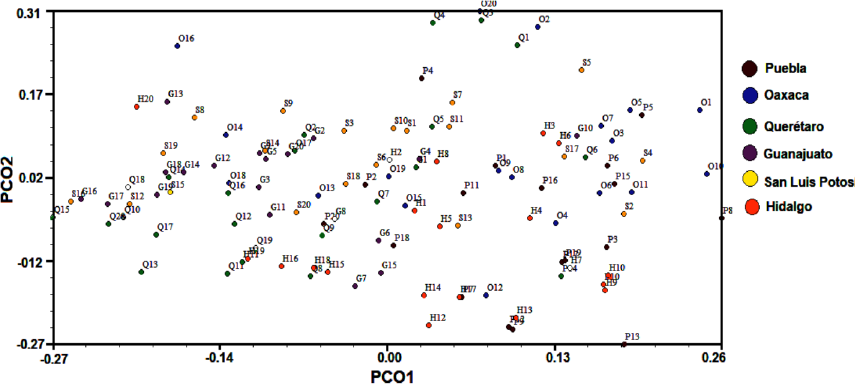
Figure 4. Two dimensional plot of the PCO-MC clustering analysis for the B. veronicifolia IPBS dataset.